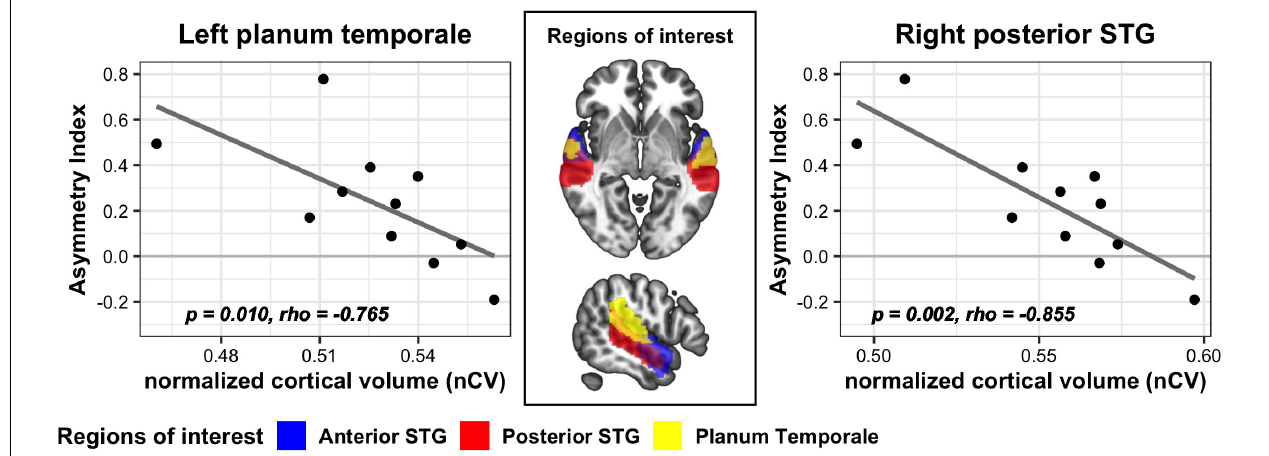
FIGURE 5 | Significant correlation between nCV and AI values in two ROIs of the SSD-R group. STG, superior temporal